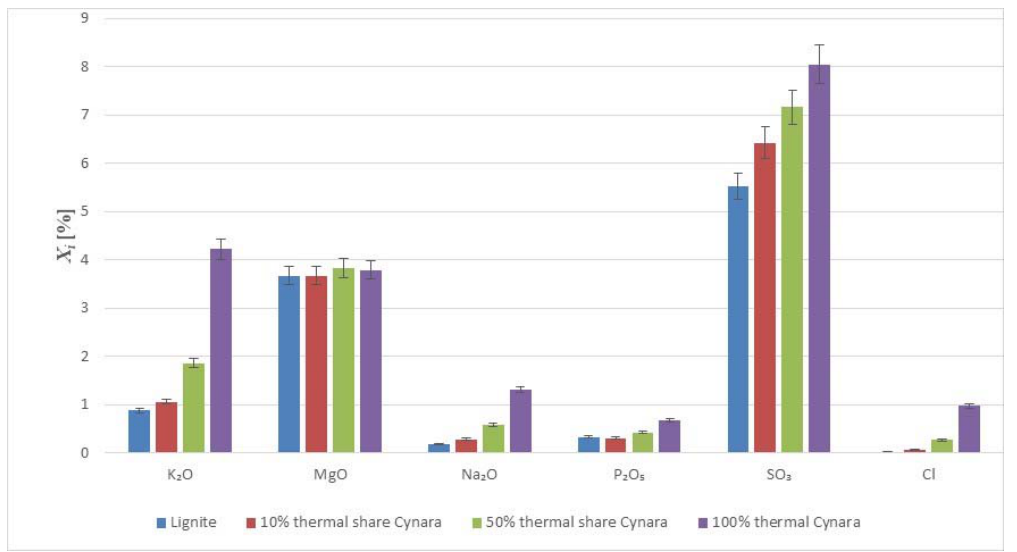
Figure 7. Major and minor oxides of fly ashes, II.